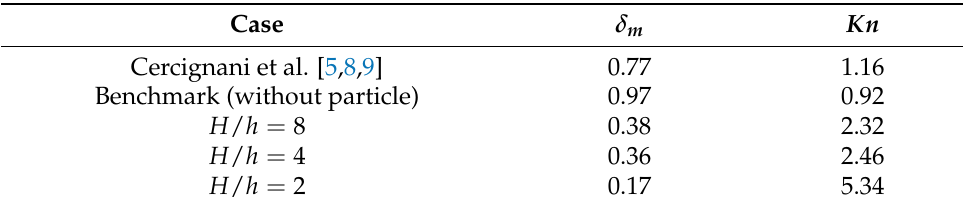
Table 2. Knudsen minimum in 2D planar micro-channel Poiseuille flows with a stationary particle in the middle. Note that the reported minima is subject to the variations in the sampled data shown in Figure